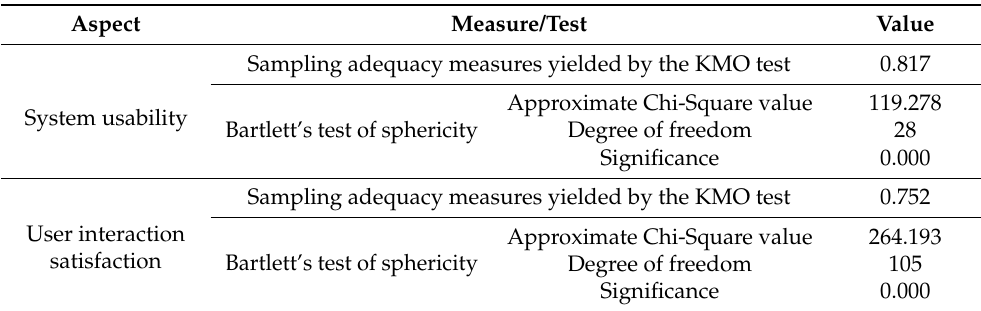
Table A3. The KMO measure values and the significance values of the Bartlett’s test of the collected questionnaire survey data of the two aspects of system usability and user interaction